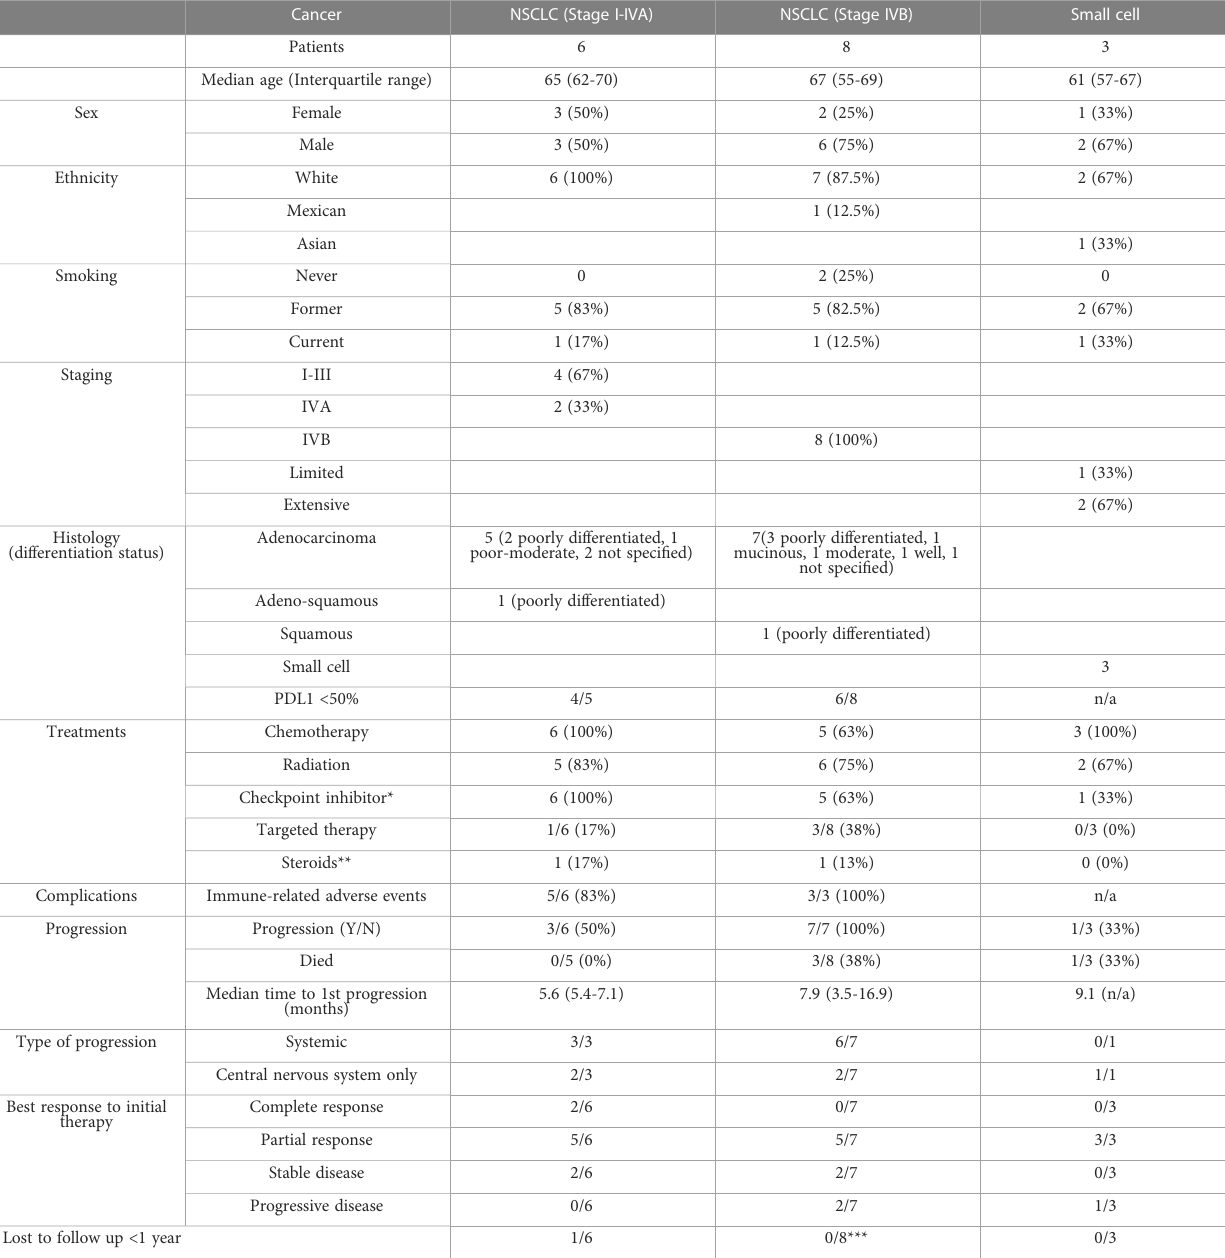
TABLE 1 Patient